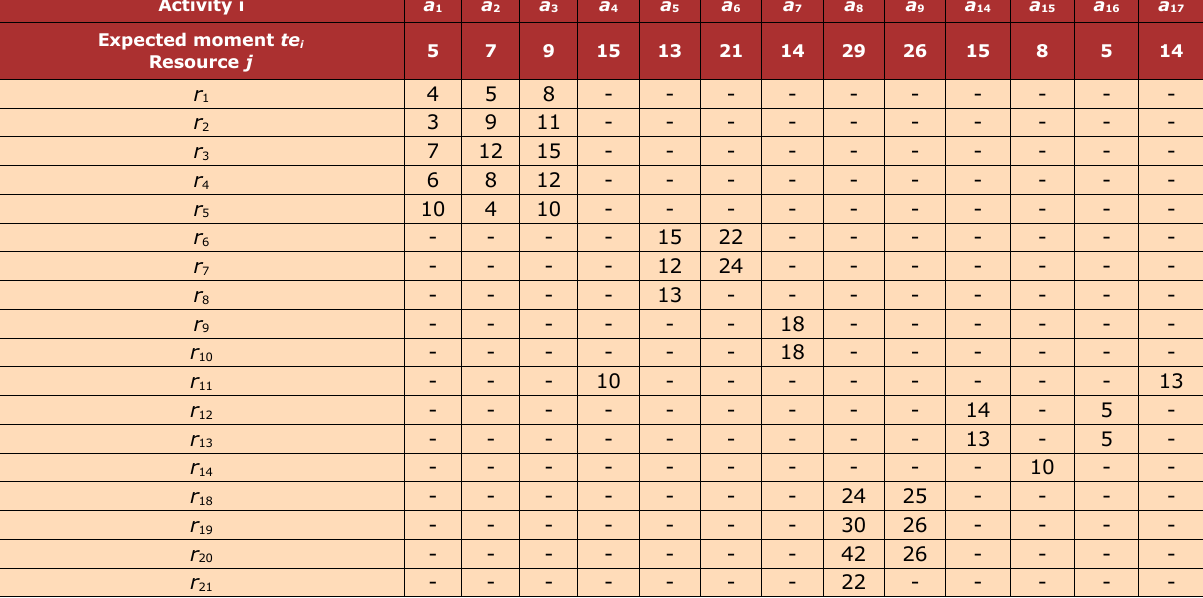
Table 2. Time information for resource-activities